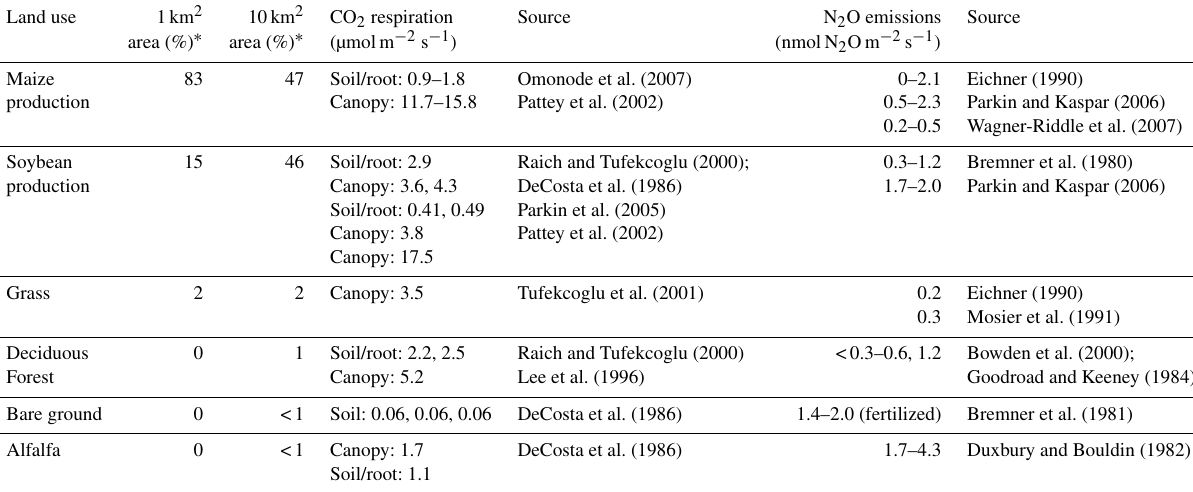
Figure 1. Experimental domain: GoogleEarth ® images from August 2015 showing the homogeneous agricultural land use across the region surrounding the experimental field (Montmorenci, Indiana, USA; 40.495 ◦ latitude and − 86.994 ◦ longitude: panel a ) and the configuration of measurements in the experimental field (panel b ). Fertilizer treatments (kgNHa − 1 season − 1 ) in the north field and south field (200Sp, 200Fa, 100Sp/100Fa, and no N) as well as the locations and heights of the sonic anemometers and inlets (open triangles), integrated line sample (open diamond and orange line), and meteorological station (open circle) are indicated in panel (b) . Note scale in lower right corner of panel (b) . Table 1. 2015 land use around the research site and literature-reported CO 2 and N 2 O fluxes for each land